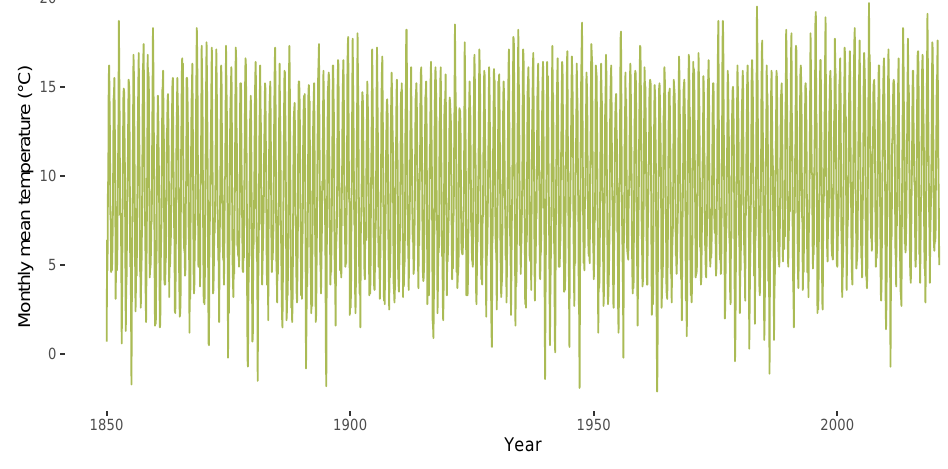
Figure 1. CET data from 1850 until 2020.